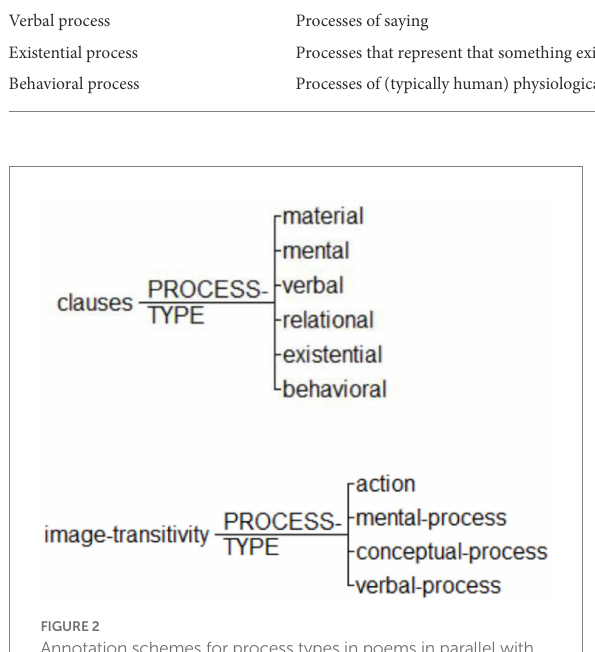
FIGURE 2 Annotation schemes for process types in poems in parallel with process types in